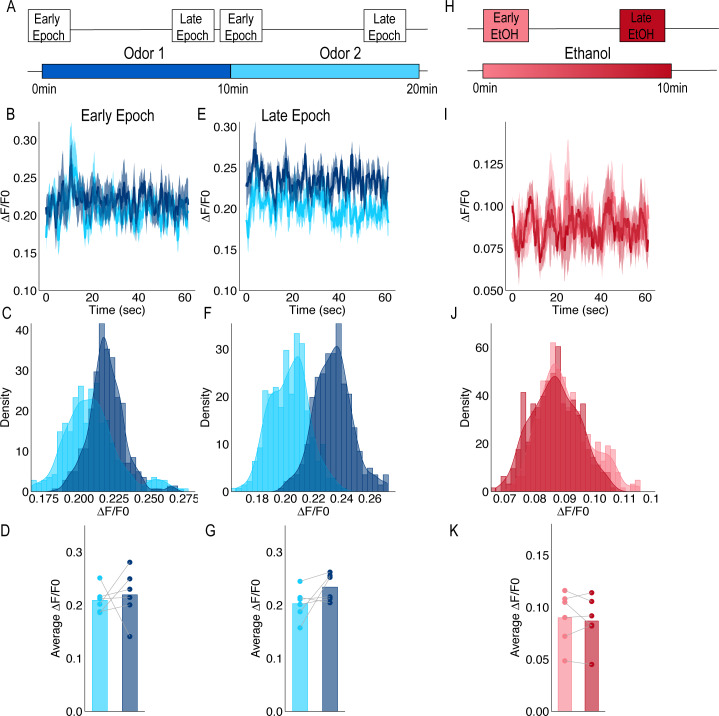
Calcium Imaging from terminals of PAM population of DANs in response to odors and ethanol.(A) Schematic of odor presentation. Flies were presented with one odor for 10 min followed by a second odor for an additional 10 min. Isoamyl acetate and isoamyl alcohol were used as odors and order was counterbalanced across animals. Images were captured for a total of 60 s during Early and Late Epochs. (B) Traces of response to Odor one and Odor two during the Early Epochs. (C) Histograms of the frequency of delta F/F0 during the Early Epoch (D) Comparison of average response to Odor one and Odor two during Early Epochs for each animal (n = 6) were not significantly different. Repeated measure ANOVA was used to compare mean and variance F(1,5)=0.144, p=0.720. (E) Traces of response to Odor one and Odor two during the Late Epochs. (F) Histograms of the frequency of delta F/F0 during the late Epoch. (G) Comparison of average response to Odor one and Odor two during Late Epochs for each animal (n = 6). Repeated measure ANOVA was used to compare mean and variance F(1,5)=3.437, p=0.123. (H) Schematic of 50% ethanol presentation. Images were captured for the entire 10 min, however, to remain consistent with other recording paradigms, only 60 s during Early and Late time points were analyzed. (I) Traces of response to ethanol during Early and Late Epochs. (J) Histograms of the frequency of delta F/F0 during the Early and Late Epochs. (K) Comparison of average response during Early and Late Epochs of ethanol were not significantly different. Repeated measure ANOVA was use to compare mean and variance F(1,5)=0.390, p=0.560.